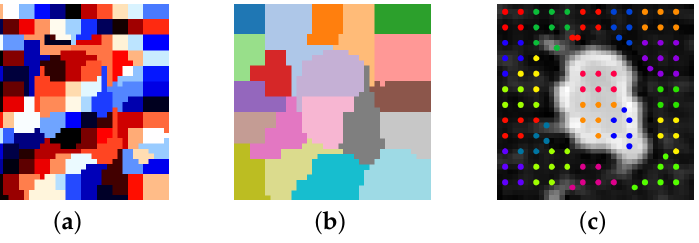
Figure 6. An example of grouping regions into clusters with k-means. ( a ) Regions. ( b ) Clusters. ( c ) Seed grouping shown over input image.